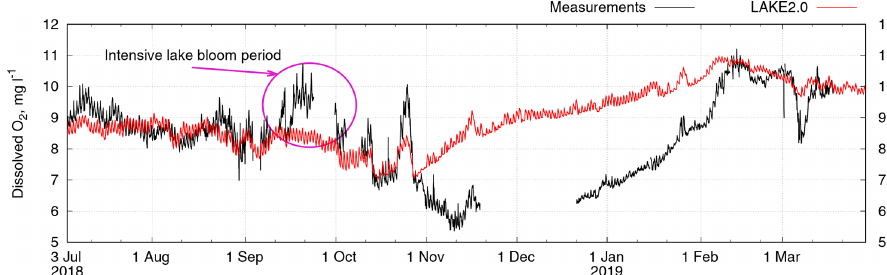
Figure 10. Profiles of dissolved O 2 in water measured during the field campaign (black) and model values (red).